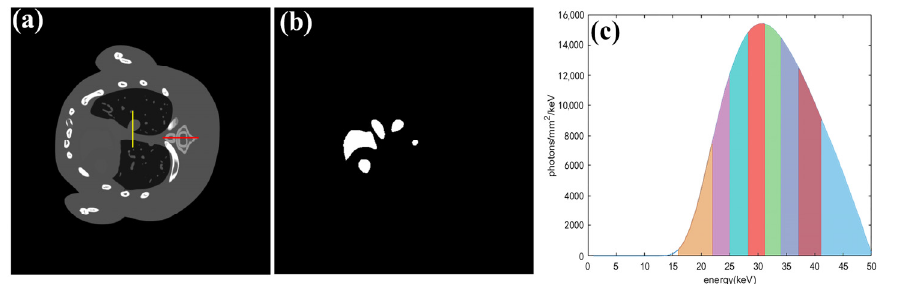
Figure 1. ( a ) Mice thorax phantom, ( b ) iodine contrast agent, ( c ) spectrum curve.